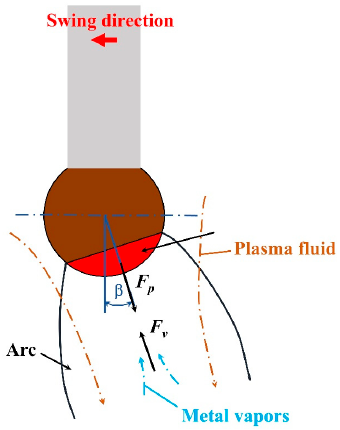
Figure 5. The plasma fl uid force and reaction force of metal vapors on the droplet.